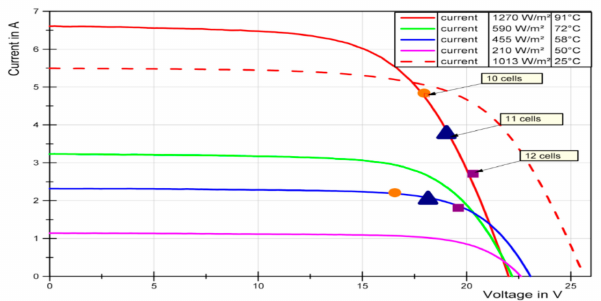
Figure 11. Variation of the electrolysis cell number and its influence on the performance of the coupled